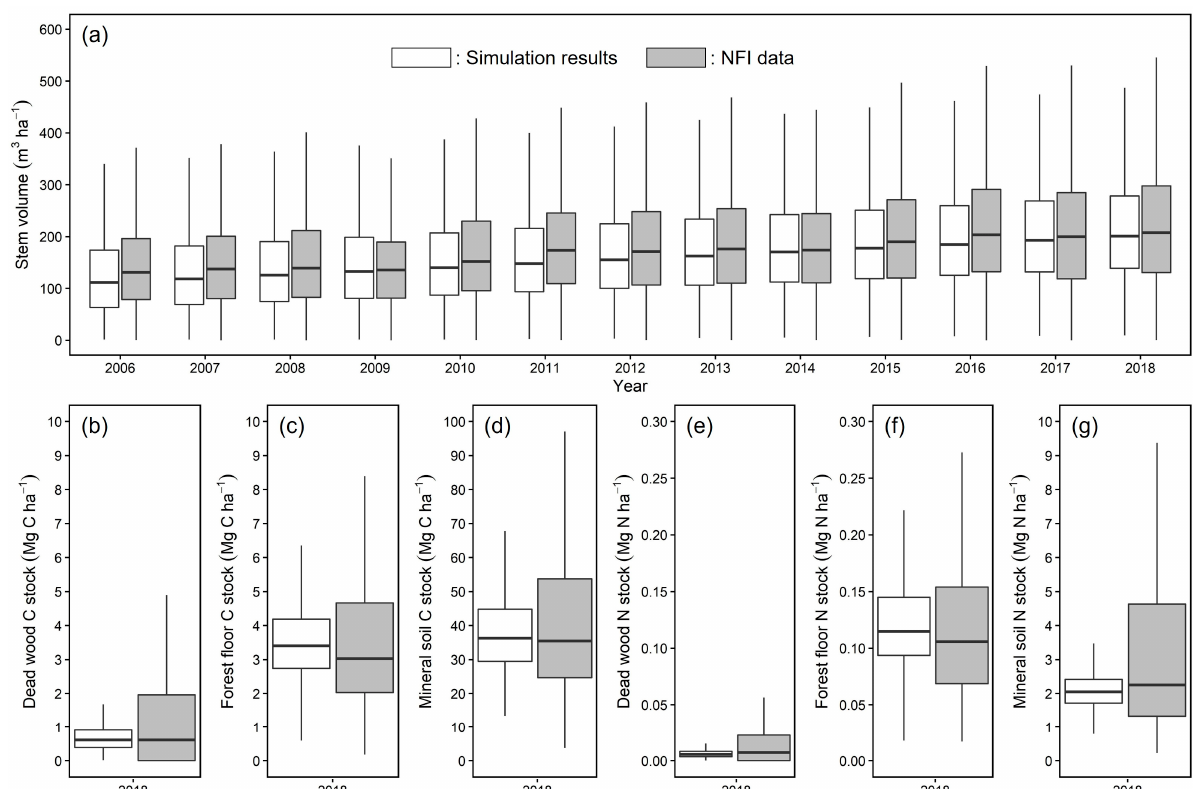
Figure 2. ( a ) Times-series comparison of the stem volume between the simulation results (white box plots) and the National Forest Inventory (NFI) data from 2006 to 2018 (gray box plots). Comparisons of ( b ) dead wood carbon (C) stock, ( c ) forest floor C stock, ( d ) mineral soil C stock, ( e ) dead wood nitrogen (N) stock, ( f ) forest floor N stock, and ( g ) mineral soil N stock between the simulation results (white box plots) and the NFI data in 2018 (gray box plots). The boxes’ lower and upper limits indicate the 25% and 75% quartile, respectively. The bold line within the boxes denotes the median. The whiskers show the range of values from the minimum to maximum.